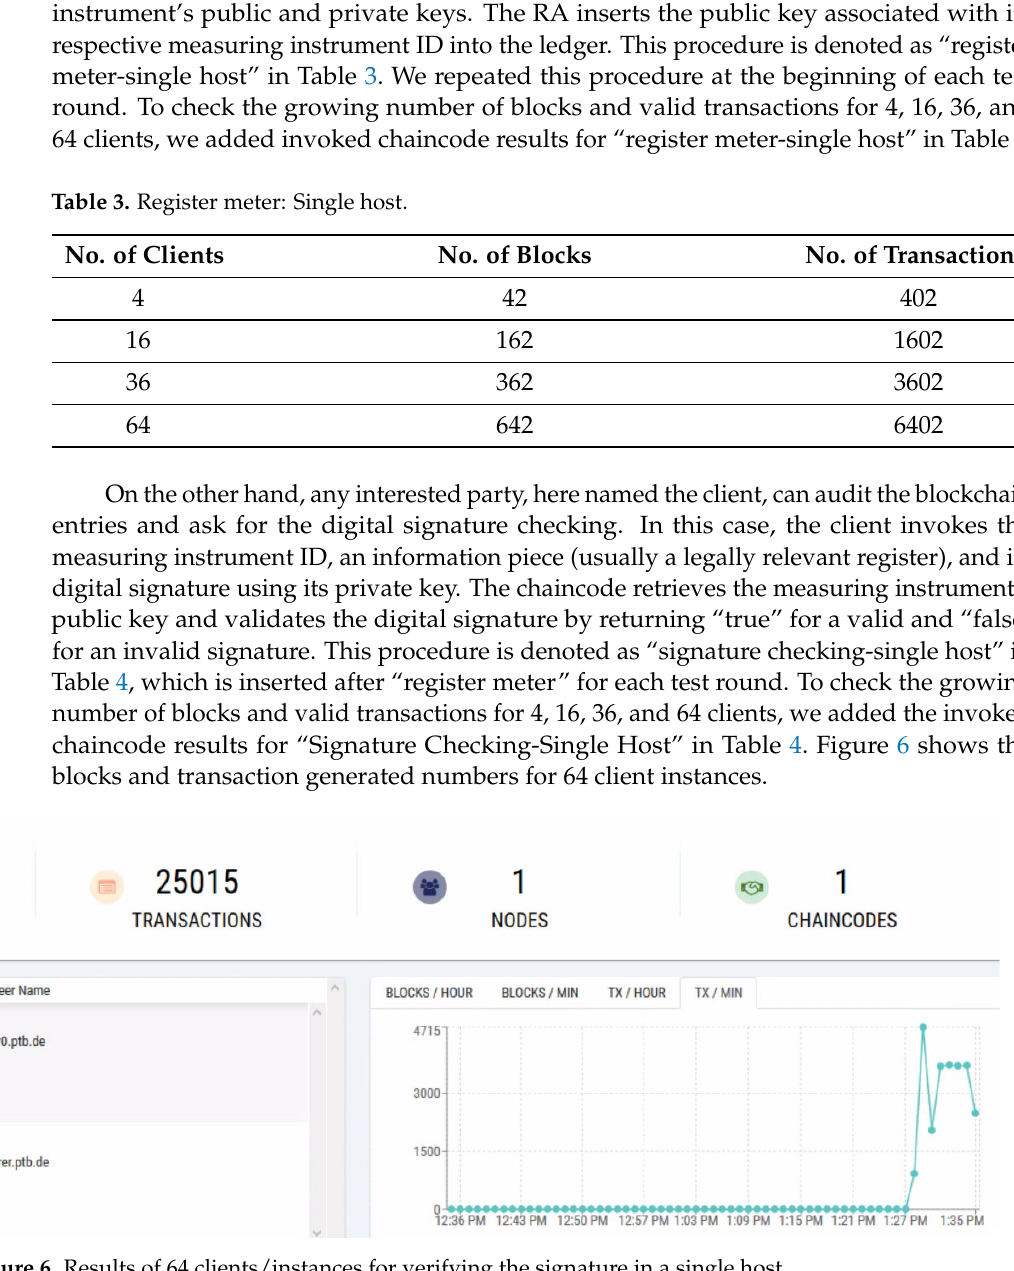
Figure 6. Results of 64 clients/instances for verifying the signature in a single